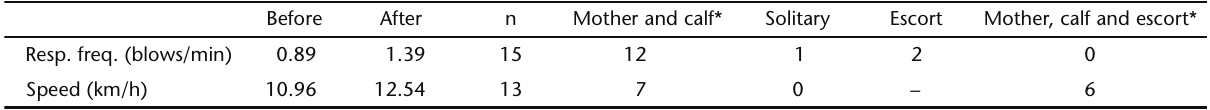
Table II. Mean values of respiratory frequency and speed, before and after tagging, and the respective sample sizes (n) of different group compositions analyzed. Speed was measured for the whole group, so the escort category was excluded. Before After n Mother and calf* Solitary Escort Mother, calf and escort*